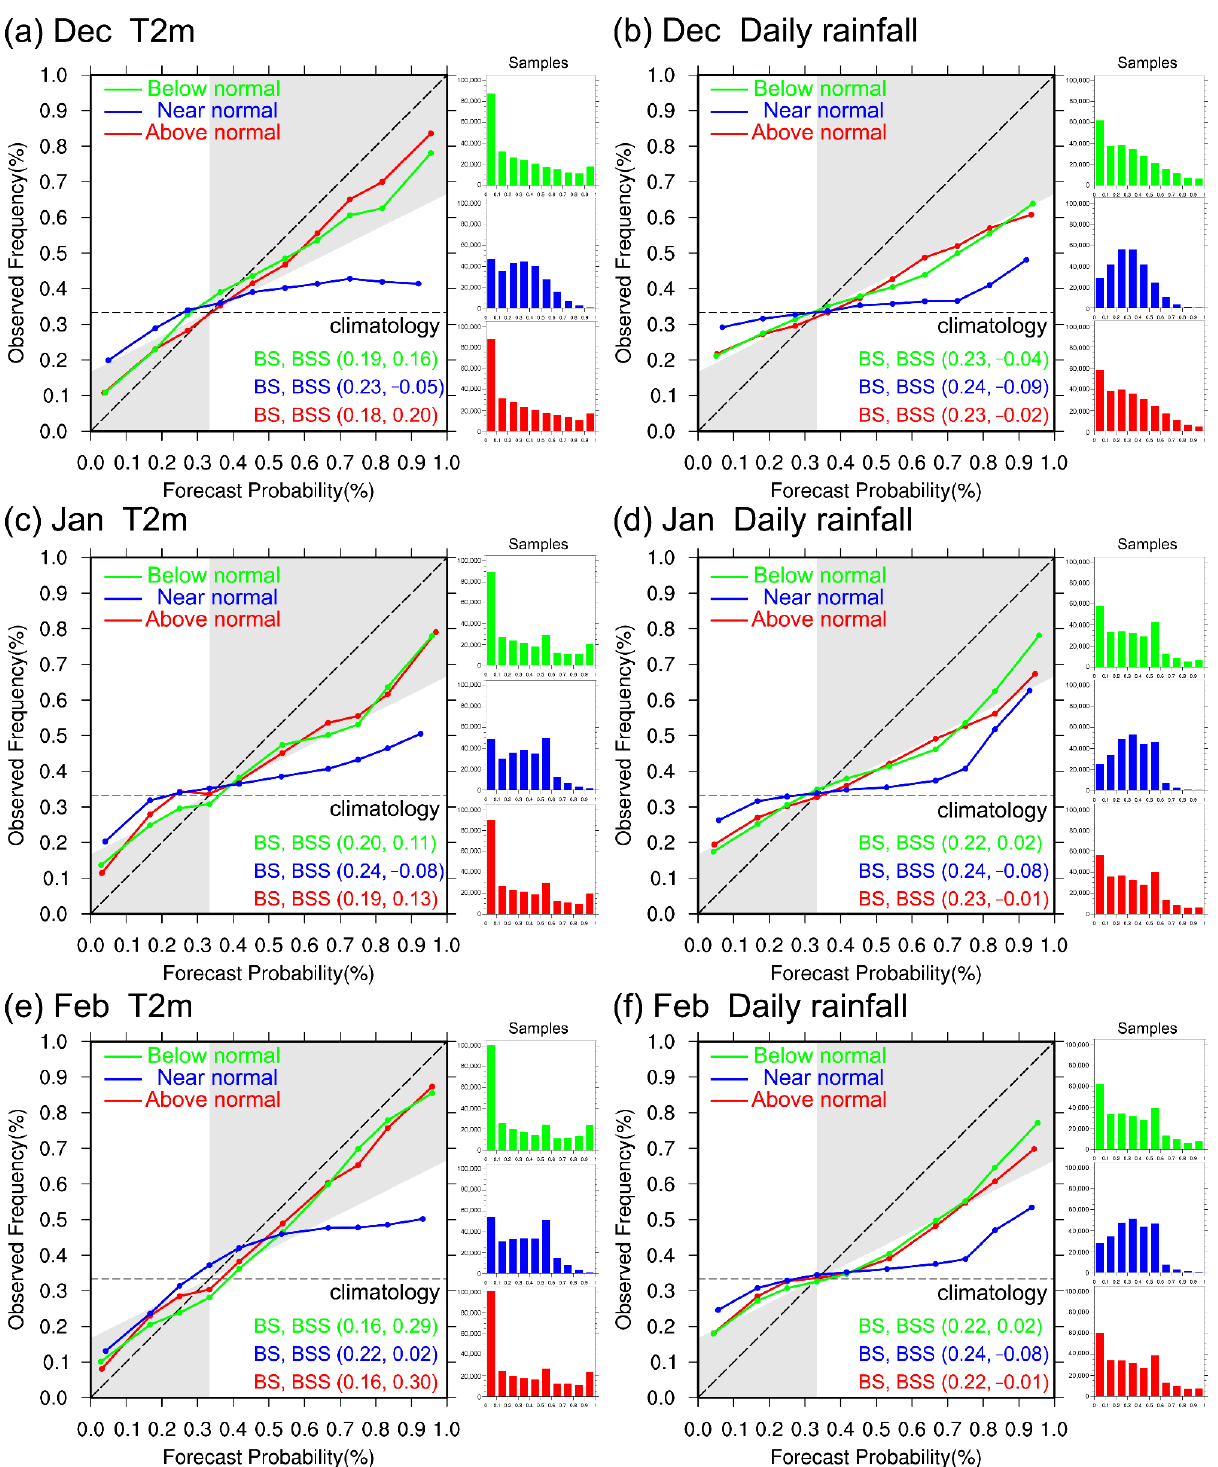
Figure 7. Reliability diagrams for the three-category probabilities of monthly averaged T2m (left column) and averaged daily rainfall (right column) on ( a , b ) December, ( c , d ) January, and ( e , f ) February. Green, blue, red lines denote the below normal, near normal, and above normal categories. The thin dashed line is 0.333 according to the observed frequency of climatology for the three-category method. The Brier score ( BS ) and the Brier skill score ( BSS ) are denoted at the right bottom of each